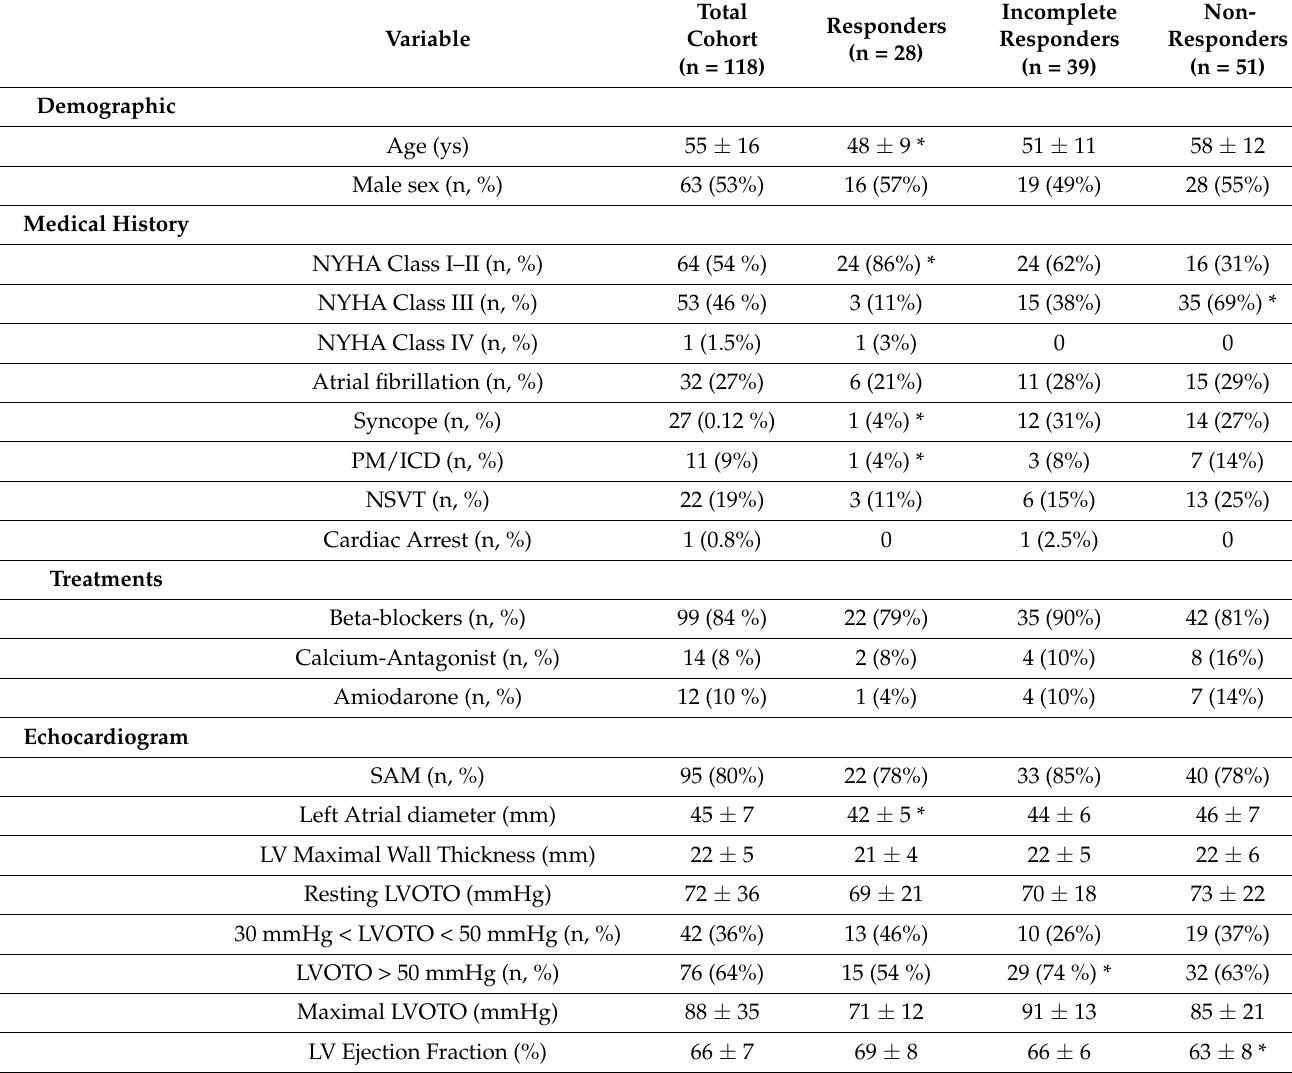
Table 1. Baseline characteristics of the cohort at disopyramide therapy